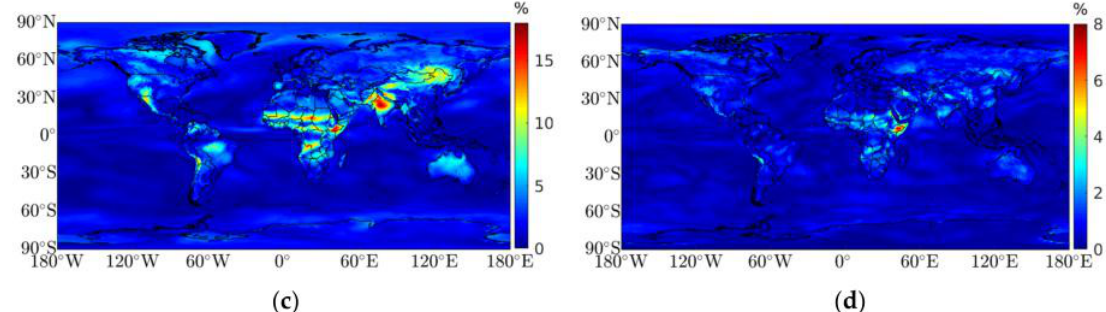
Figure 1. Global distribution of mean coefficients for relative humidity: ( a ) mean values (%); ( b ) mean annual amplitude contribution (%); ( c ) mean semi-annual contribution (%); and ( d ) mean quarterly contribution